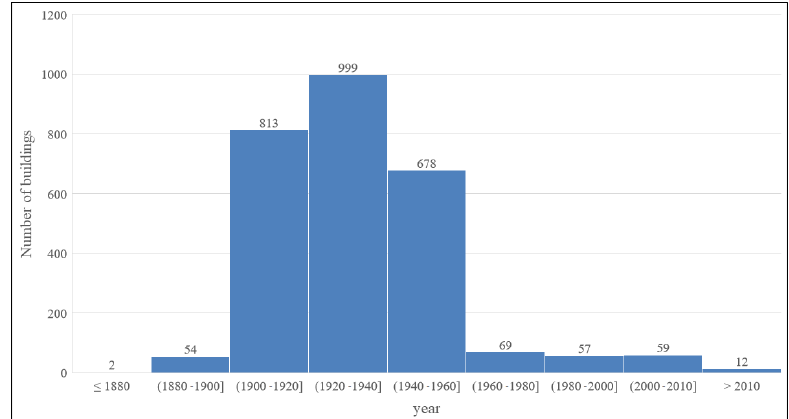
Figure 4. Building year built in Pocatello Old Town.